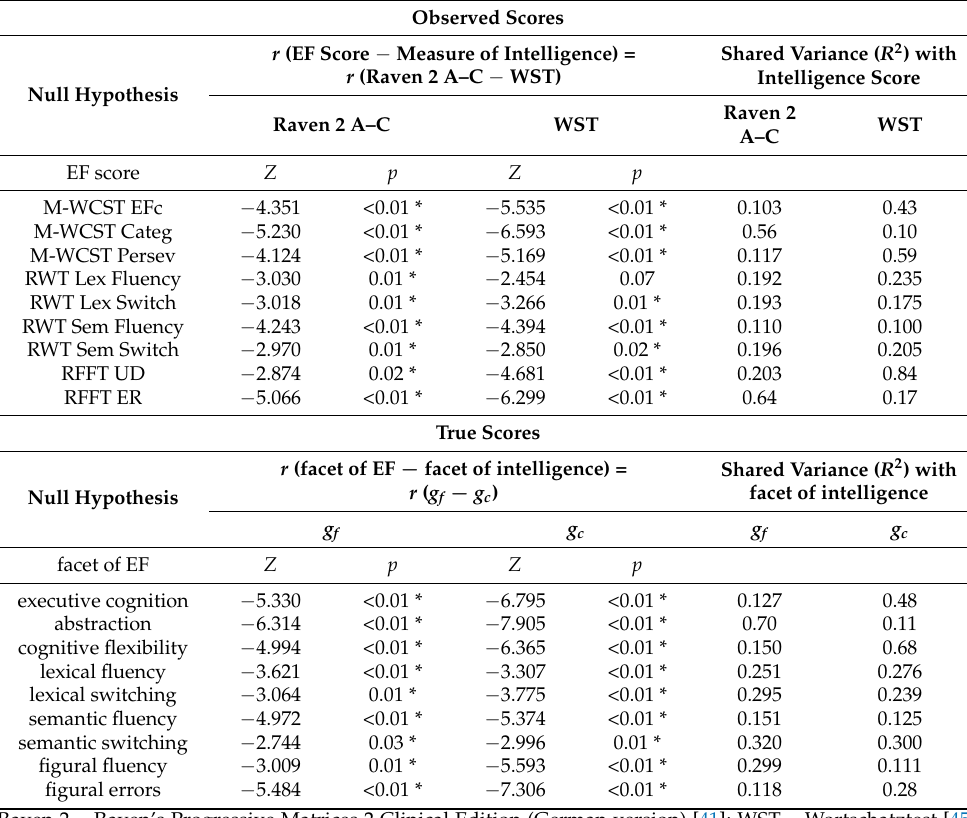
Table 6. Discriminant validity of executive functioning (EF) assessments against measures of intelligence. Observed